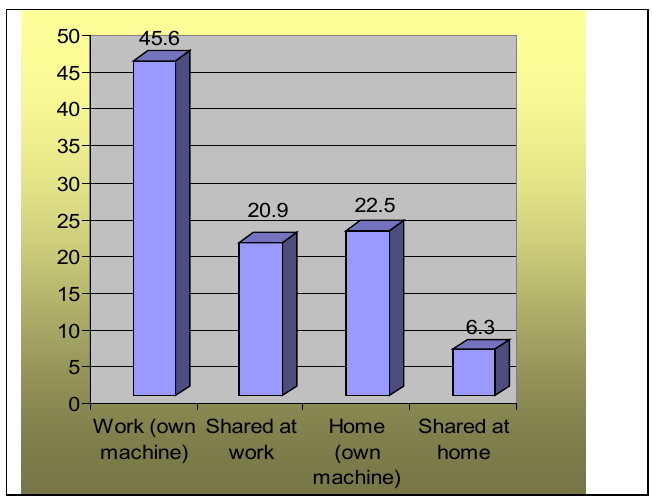
Figure 1 . Internet access